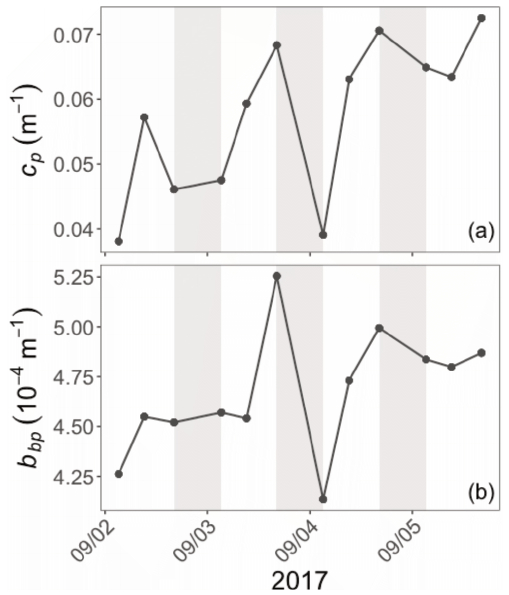
Figure 5. Example of the variations of the c p (a) and b bp (b) co- efficients at the daily timescale in the Ionian Sea in the SCM layer during the interval from 2 to 6 September 2017. The grey-shaded area indicates the nighttime. Please note that the date format in this figure is